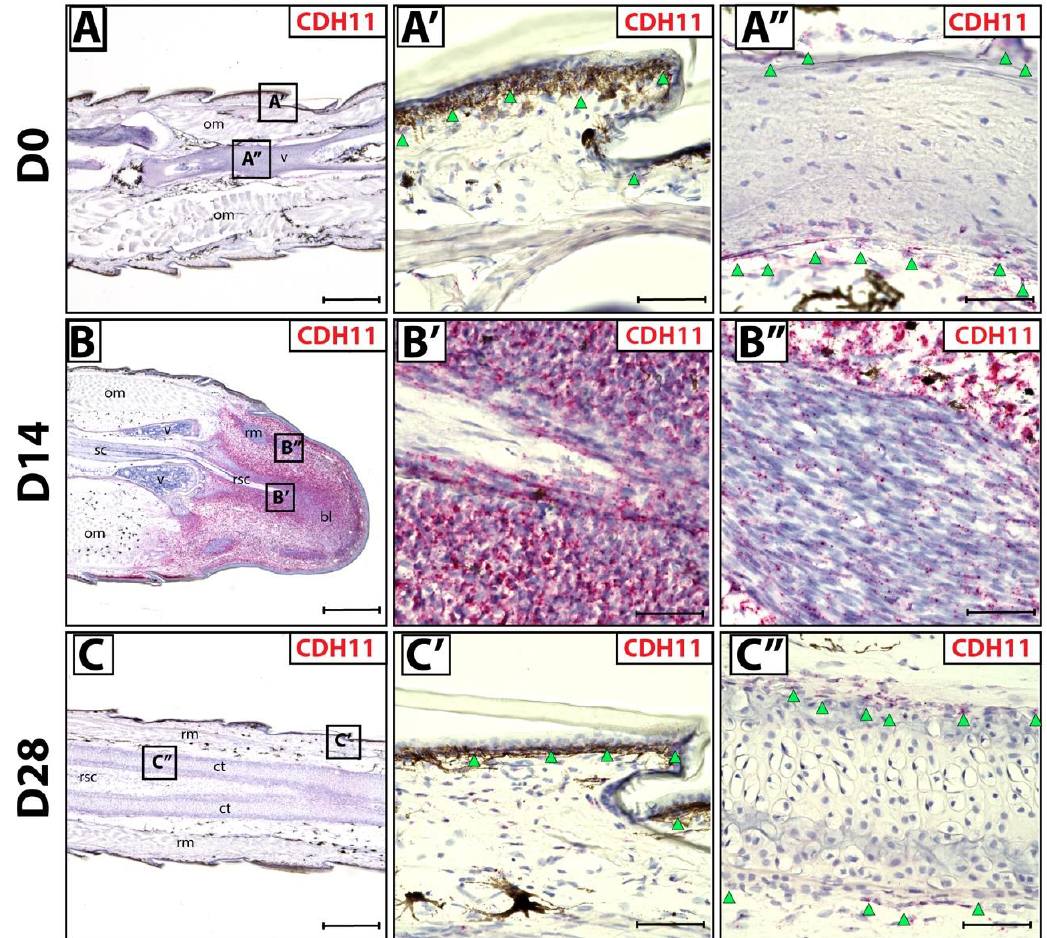
Figure 1. CDH11 + cells in original and regenerating lizard tails. ( A ) Original tail (D0), ( B ) blastema (D14) and ( C ) regenerated tail (D28) analyzed by histology/in situ hybridization for CDH11 expres- sion. ( A’ , A’’ ) Higher magnification views of original tail regions identified in Panel A highlighting CDH11 expression in ( A’ ) epidermis (green arrowheads) and ( A’’ ) periosteum (green arrowheads). ( B’ , B’’ ) Higher magnification views of tail blastema regions identified in Panel B contrasting ( B’ ) high CDH11 expression in blastema connective tissue and ( B’’ ) low expression in blastema muscle bundles. ( C’ , C’’ ) Higher magnification views of regenerated tail regions identified in Panel C in- cluding ( C’ ) regenerated epidermis (green arrowheads) and ( C’’ ) perichondrium (green arrow-